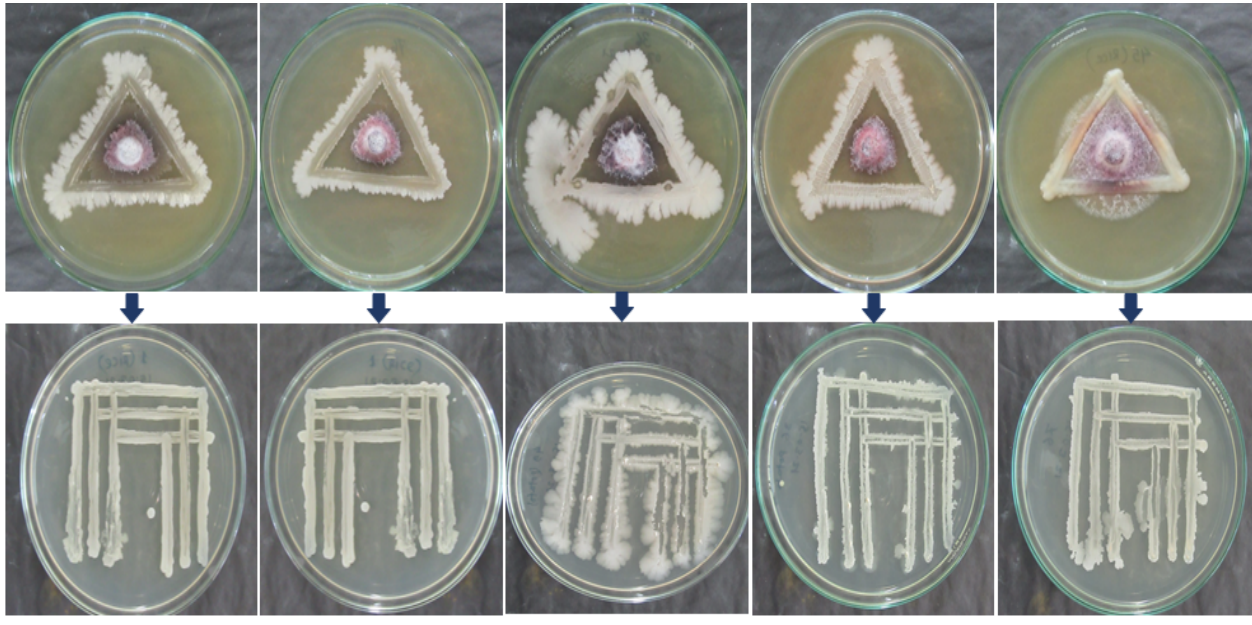
Figure 1. In Vitro growth inhibition of Fusarium proliferatum by different Bacillus species on PDA plates at 7 DAI (BDISO01RR: Bacillus amyloliquefaciens , BDISO76MR: Bacillus subtilis , BDISO36PR: Bacillus subtilis , BDISO45PR: Bacillus subtilis and BDISO49PR: Bacillus subtilis ). On the other hand, at 7 DAI, the minimum (11.75 mm) mycelial growth was observed in the case of BDISO76MR ( B. subtilis ) which was statistically similar to BDISO01RR ( B. amyloliquefaciens ) (12 mm) and BDISO45PR ( B. subtilis ) (12.25 mm) reducing the mycelial growth 85.31%, 85%, and 84.69%, respectively, over control (Table 1; Figure 1). However, among the bacterial species, the maximum (18 mm) mycelial growth was observed by BDISO49PR ( B. subtilis ), which was statistically similar to BDISO36PR ( B. subtilis ) (14 mm) B. subtilis strain PB1 (accession number KU904502.1) (Table S2). This result indicates